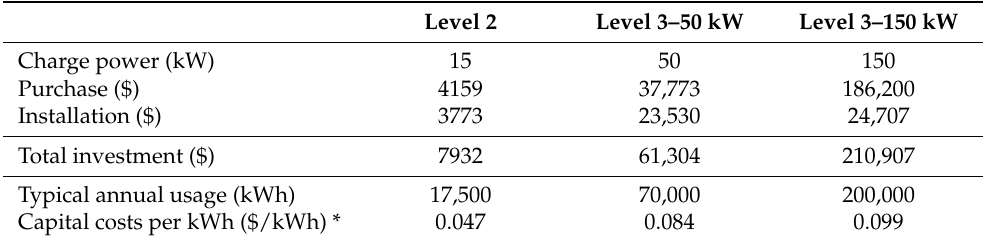
Table 3. Investments costs for electric vehicle chargers and calculated capital costs per kWh of recharging.